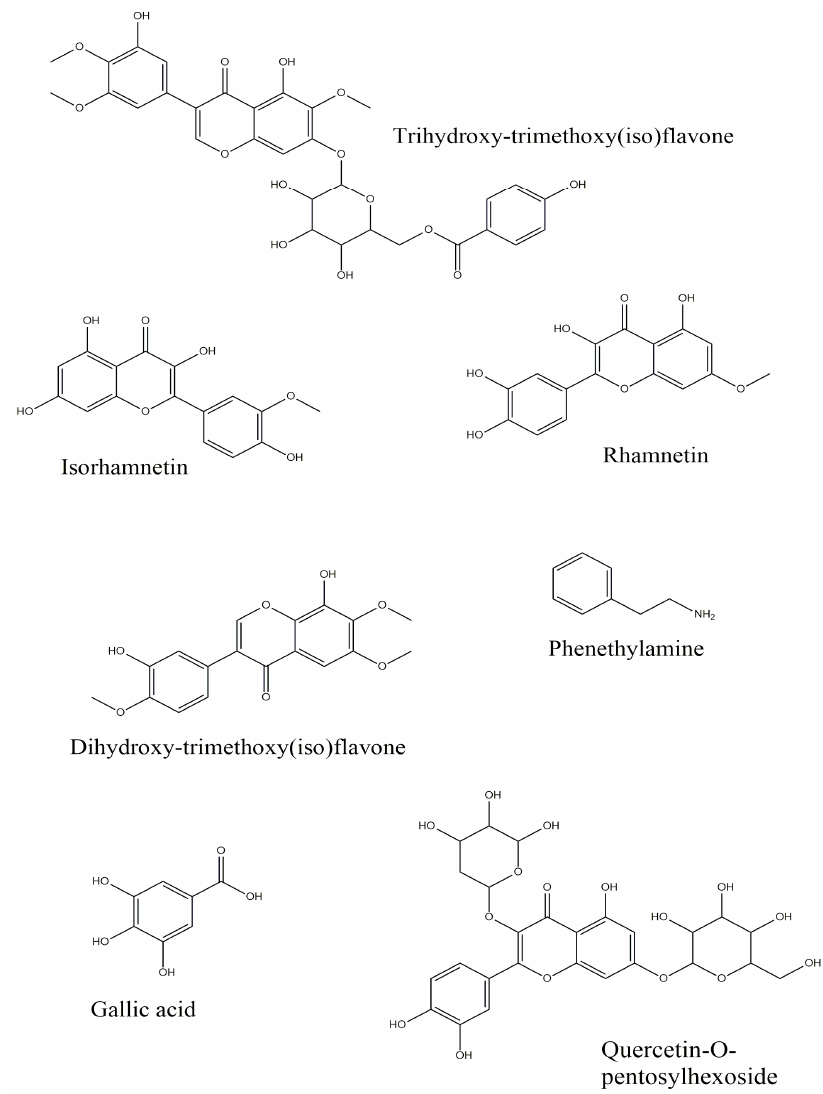
Figure 3. Structures of some compounds in the tested